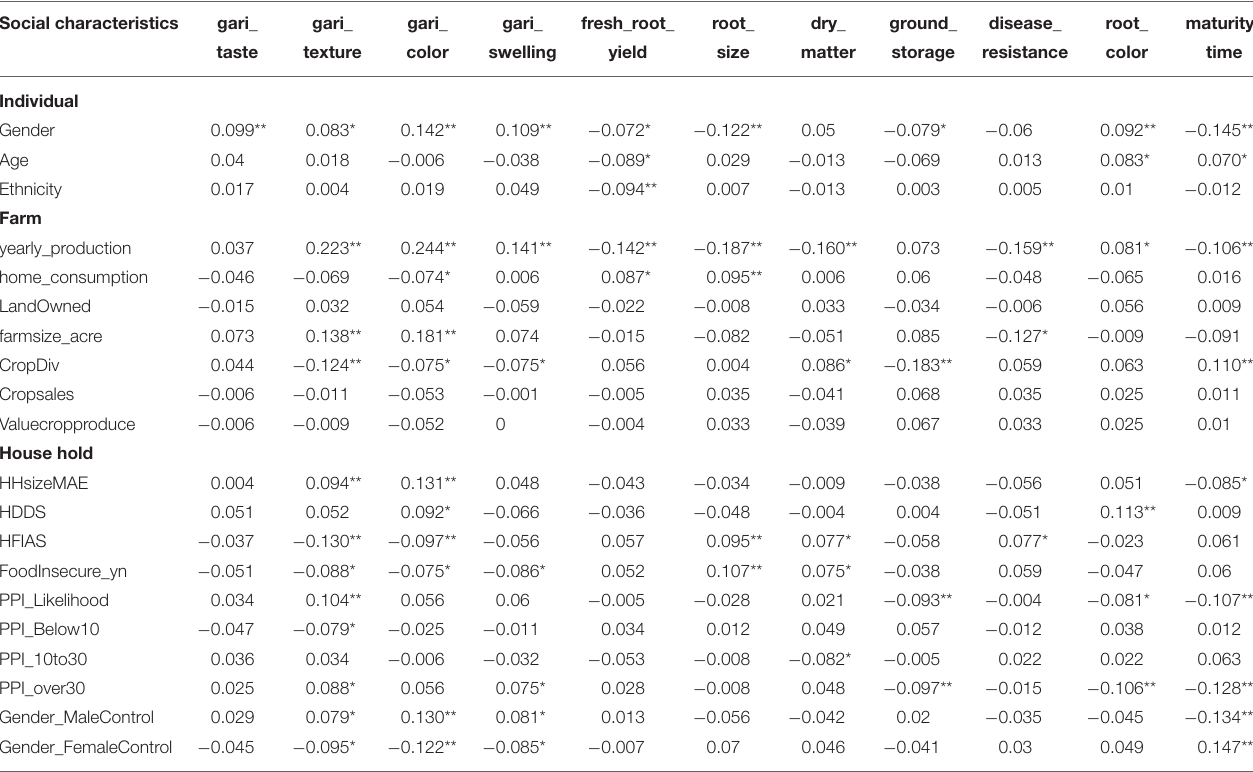
TABLE 1B | Pearson correlations between cassava traits and selected social characteristics. Social